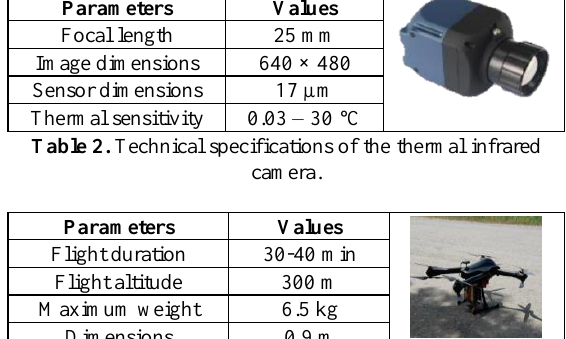
Table 1. Comparison of criteria parameters of GRIC. The saving model component  12 d